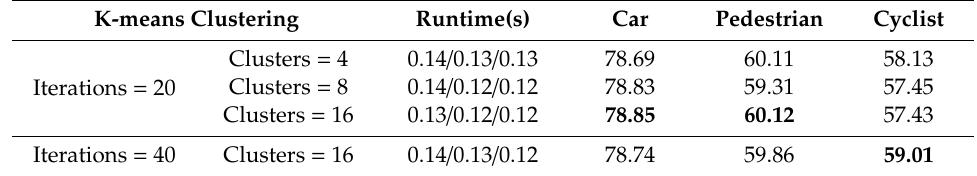
Table 4. Comparison of di ff erent K-means clustering settings: Average Precision (AP 3D in %) of 3D boxes on KITTI’s val set at “Moderate” di ffi culty. We use a 3D IoU threshold of 0.7 for the car class and 0.5 for the pedestrian and cyclist classes. The setting in the third row is KDA3D’s final